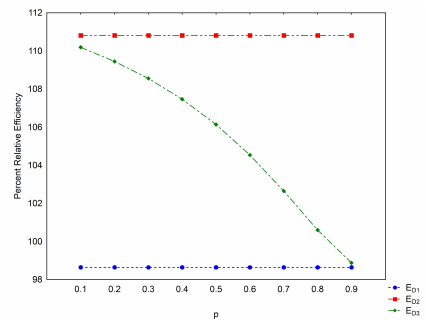
Figure 1 – Percent relative efficiencies with respect to direct method under three scrambled re- sponse models in two occasions successive